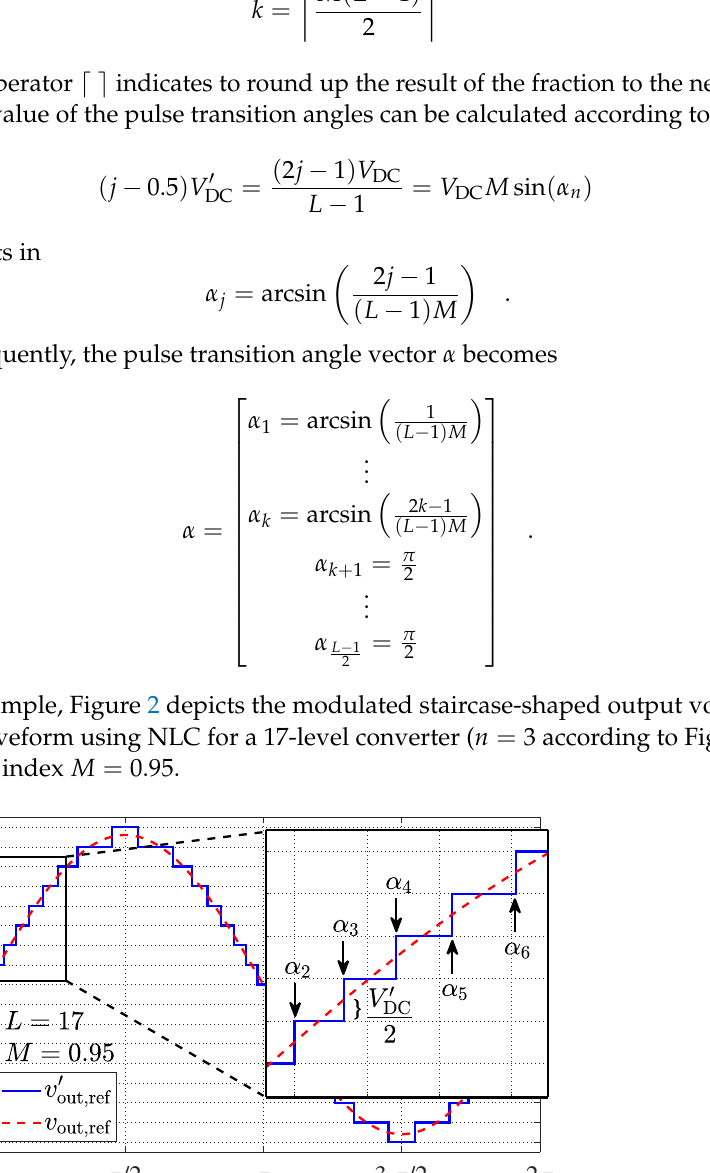
using nearest-level control for a out,ref